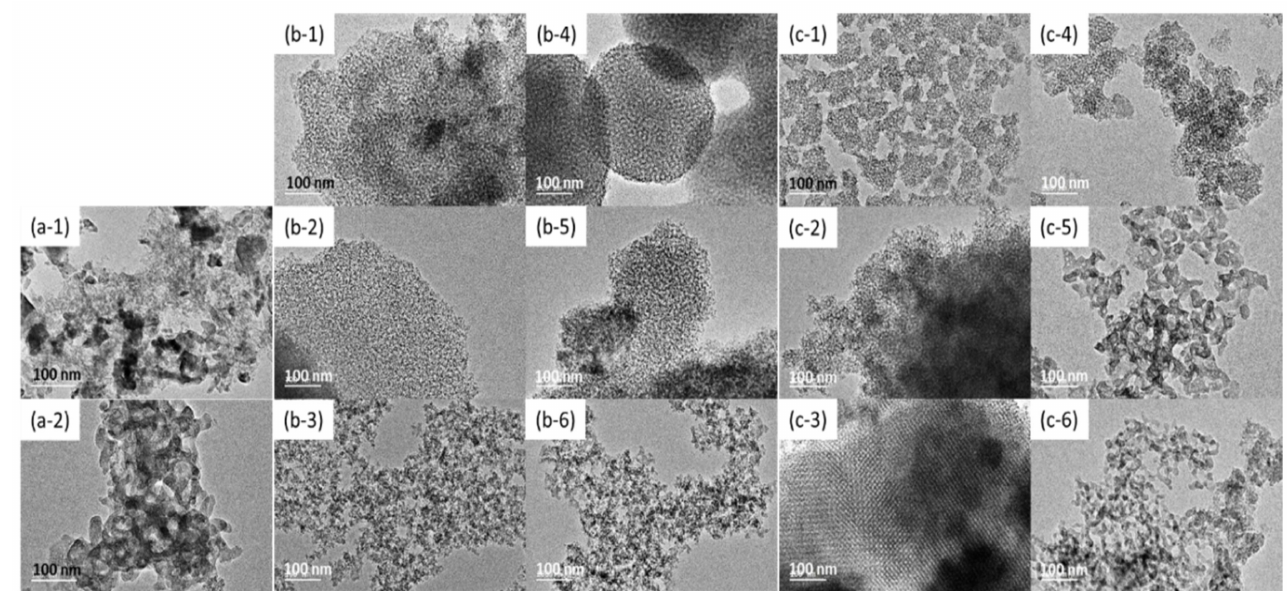
Figure 1. TEM images of mesoporous silica samples: PMSF-1 ( a-1 ), PMSF-2 ( a-2 ), PMSA-1 ( b-1 ), PMSA-2 ( b-2 ), PMSA-3 ( b-3 ), PMSA-4 ( b-4 ), PMSA-5 ( b-5 ), PMSA-6 ( b-6 ), PMSB-1 ( c-1 ), PMSB-2 ( c-2 ), PMSB-3 ( c-3 ), PMSB-4 ( c-4 ), PMSB-5 ( c-5 ), PMSB-6 ( c-6 ).